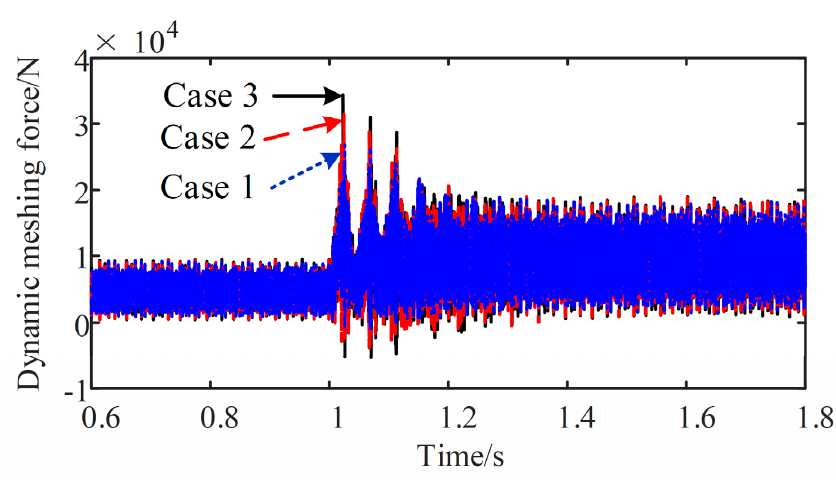
Figure 21. The meshing force of the first gear pair with different connection stiffness.